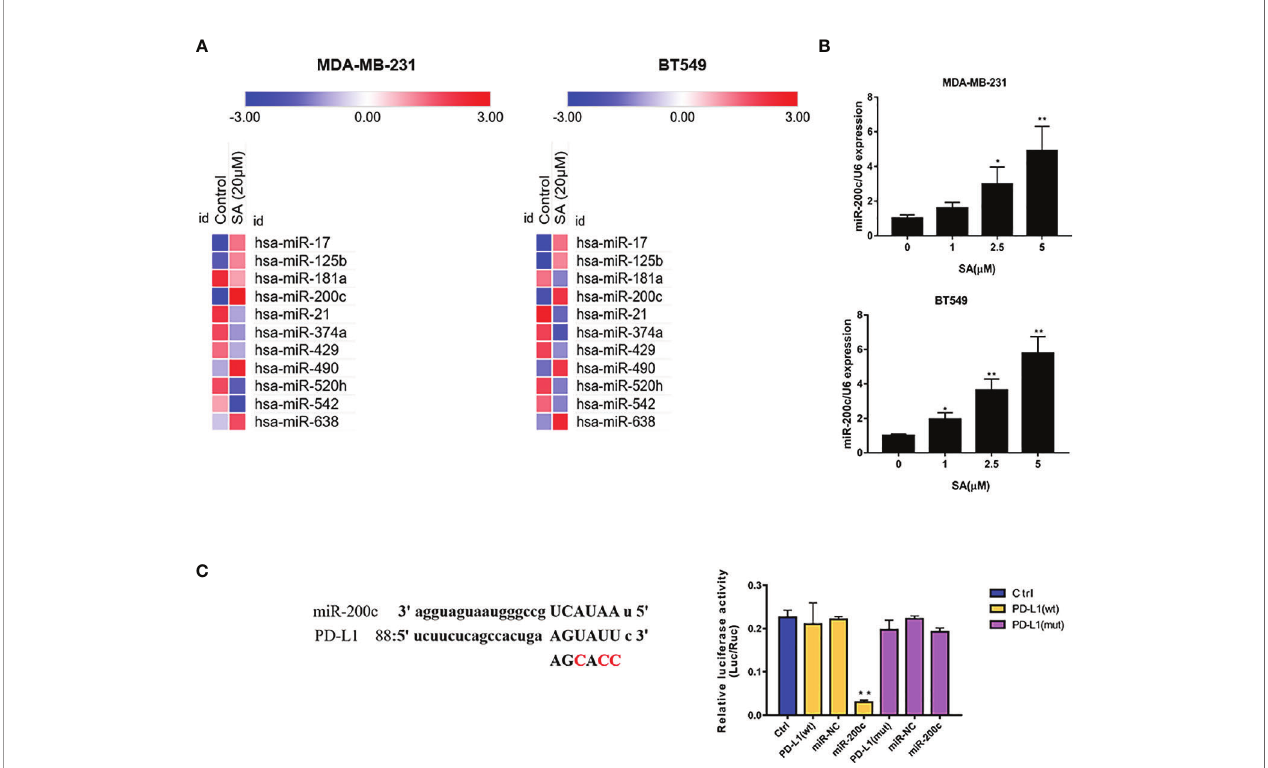
FIGURE 5 | SA increases miR-200c in TNBC cells. (A) PCR arrays screened the most signi fi cant variation of miRNAs expression in TNBC cells after SA treatment. (B) Real-time PCR analysis of miR-200c in MDA-MB-231 and BT549 cells after SA treatment. (C) Dual luciferase reporter assay con fi rmed the direct binding of miR- 200c to 3 ′ UTR of PD-L1 in 293 T cells (Compared to the control group, ** p <